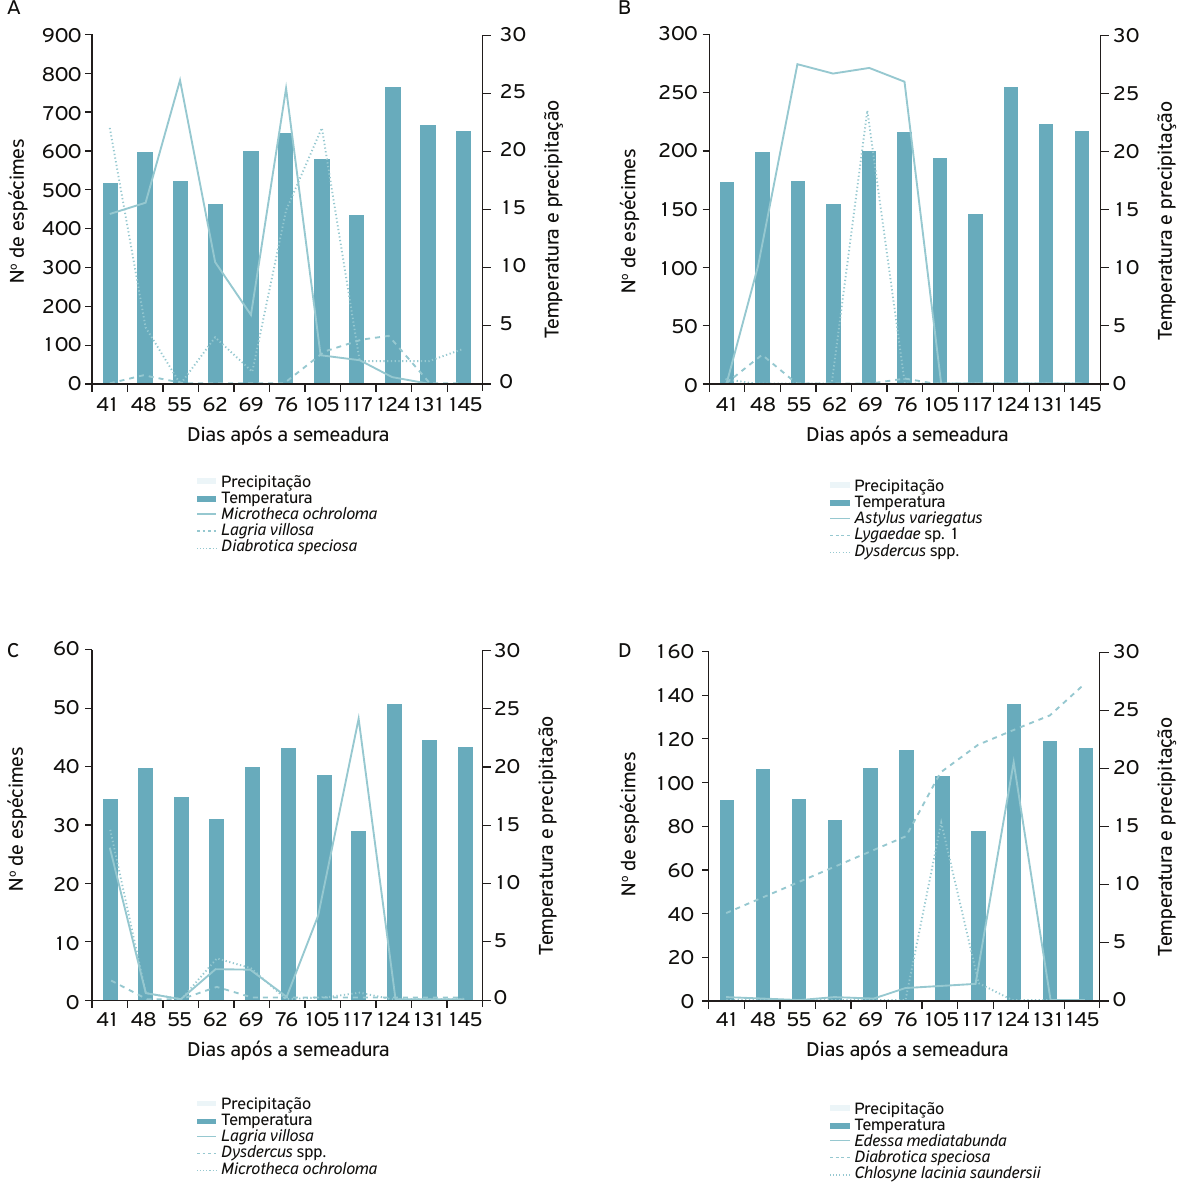
Figura 1. Flutuação populacional de insetos e parâmetros climáticos; (A) nabo forrageiro; (B) niger; (C) crambe; (D) girassol. Dourados (MS),